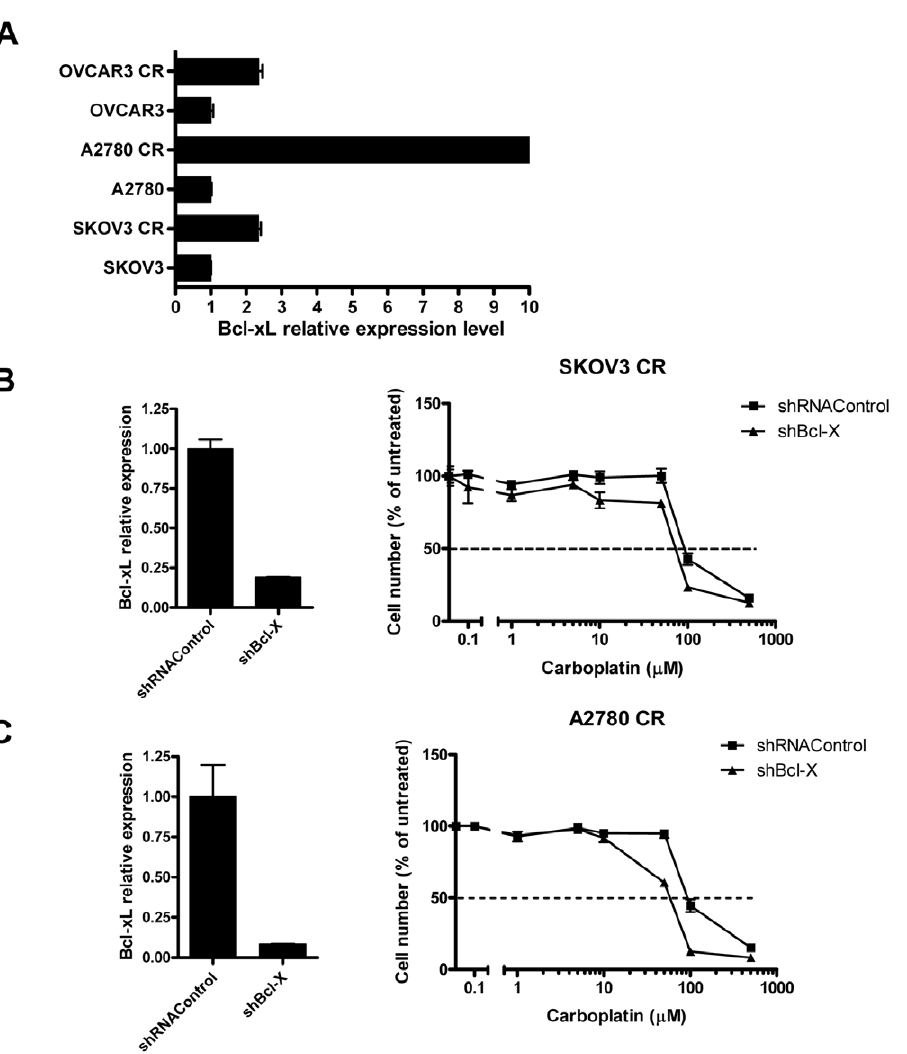
Figure 5. The expression level of Bcl-xL is increased in chemoresistant cells and its suppression reduces carboplatin resistance. A) mRNA expression of Bcl-xL in carboplatin-resistant and naı¨ve ovarian cancer cells based on qRT-PCR. B and C) Knockdown effect of Bcl-xL shRNA in SKOV3-CR cells (B) and in A2780-CR cells (C). After transfection with Bcl-xL shRNA and selection with puromycin for 5–7 days, Bcl-xL expression level decreases (left panels). The cells were then treated with carboplatin at various concentrations for 4 days. IC 50 curves were determined using cell viability assay (right panels).